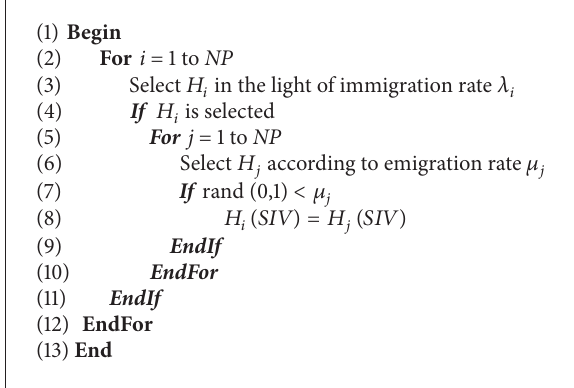
Algorithm 1: Pseudocode of migration